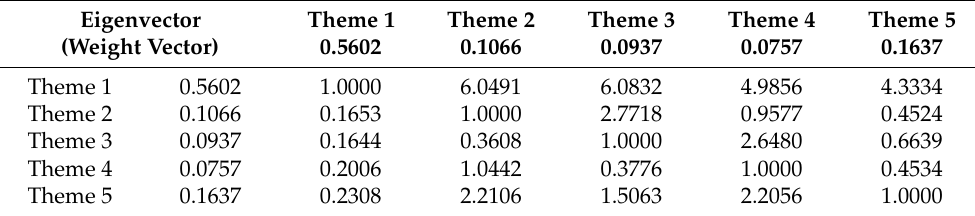
Table 6. The aggregated PCM and resulting weights for ‘UK Experts’ at the themes level.